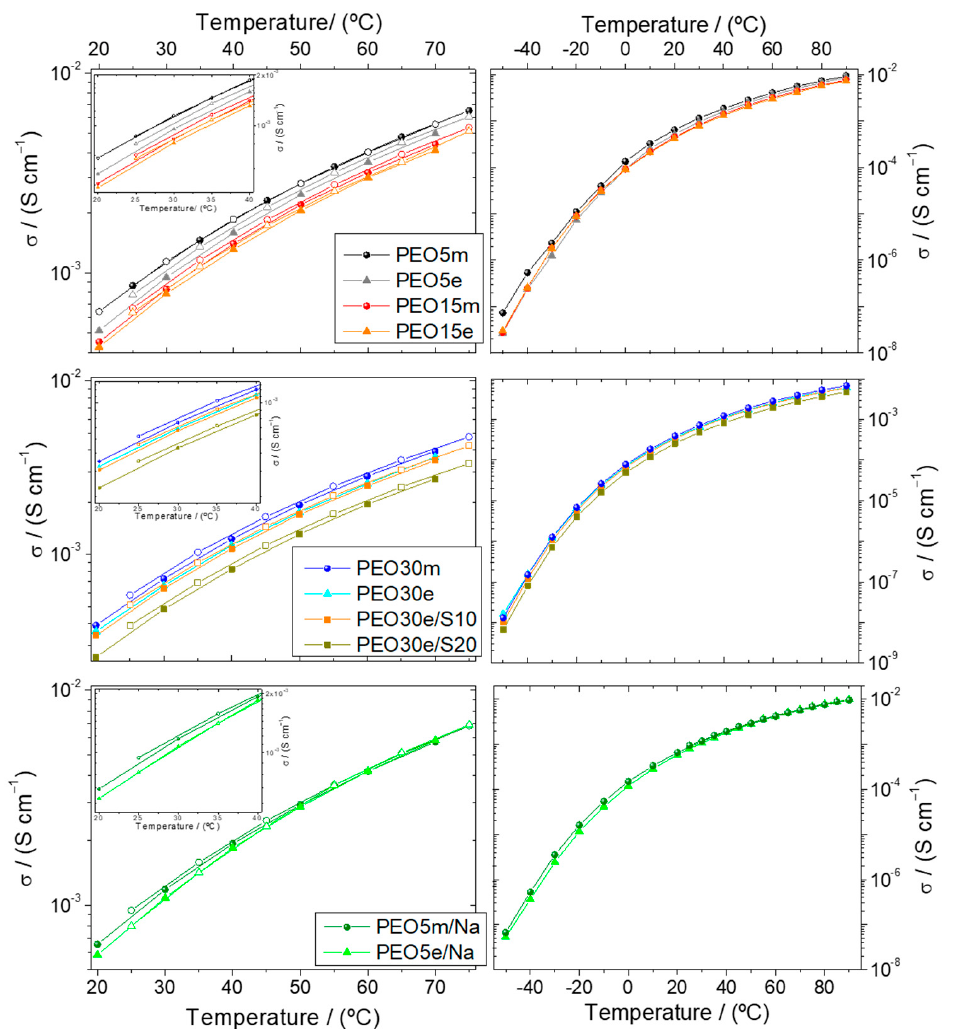
Figure 5. σ (T) of the gel electrolytes. Heating from 20 to 75 °C on left column and from − 50 to 90 °C on right column. Solid symbols for heating and open symbols for cooling.